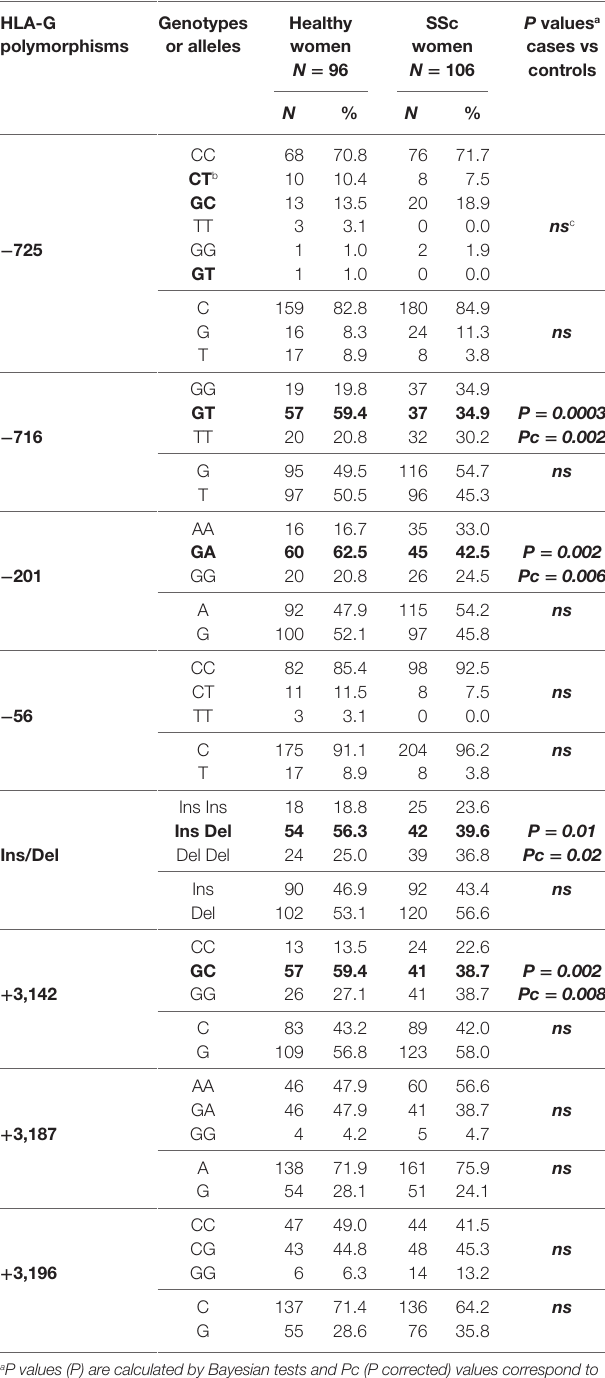
TaBle 3 | Genotype and allele frequencies of eight human leukocyte antigen-G (HLA-G) polymorphisms in healthy and SSc women.